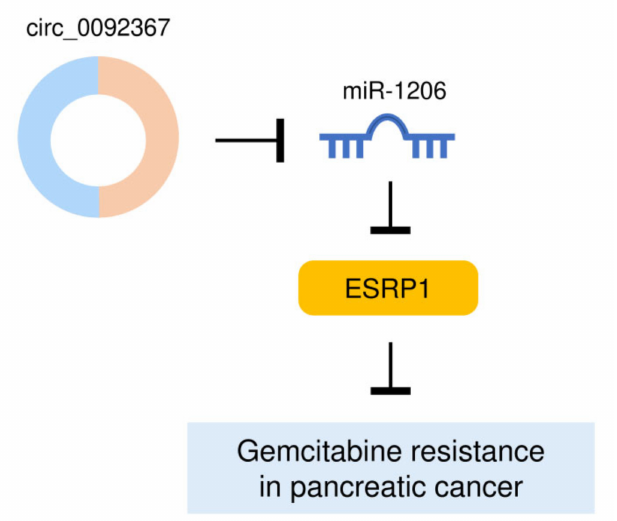
Figure 10. A Model Showing That Circ_0092367 Reverses PC Gemcitabine by Regulating the MiR- 1206/ESRP1